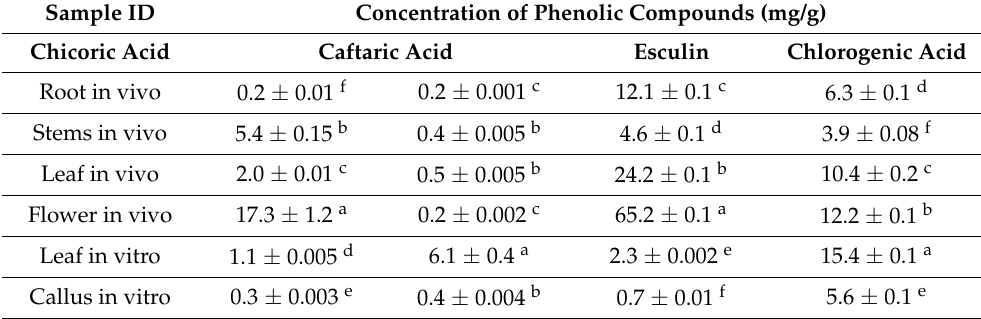
Table 2. Phenolic compositions of Cichorium intybus L.